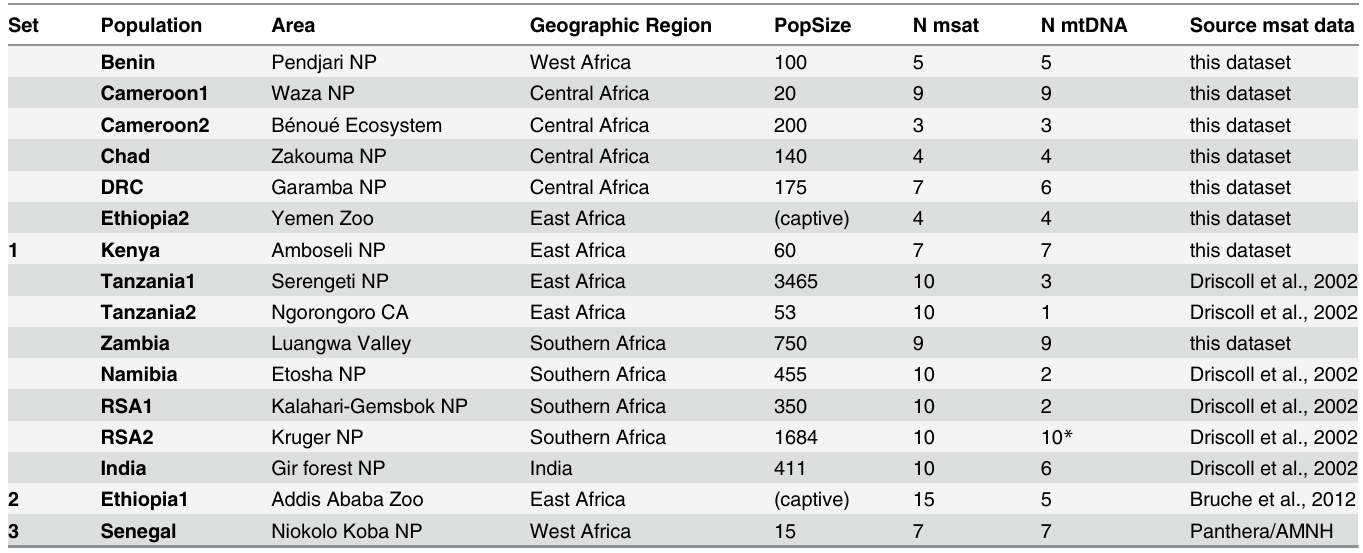
Table 1. Overview of lion populations included in this